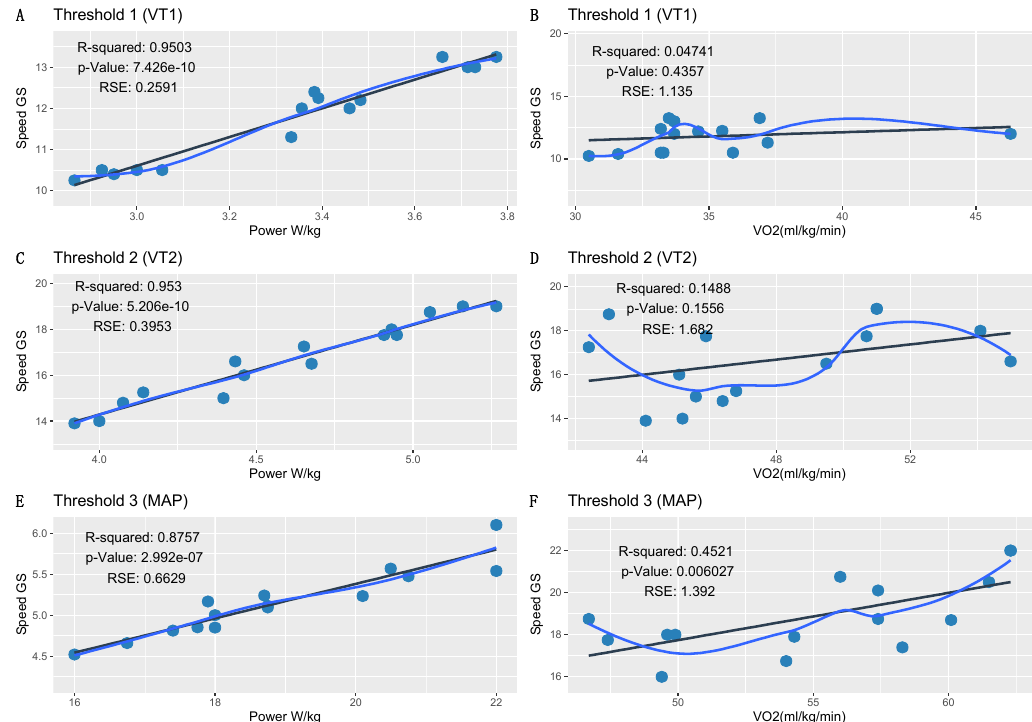
Figure 2. Regression models for power (W) and maximum oxygen consumption (VO 2 max) with respect to speed. The regression models compared power and VO 2 max with speed at ventilation threshold 1 (VT1; A , B ), ventilation threshold 2 (VT2; C , D ), and at the maximal aerobic power (MAP) threshold ( E , F ).